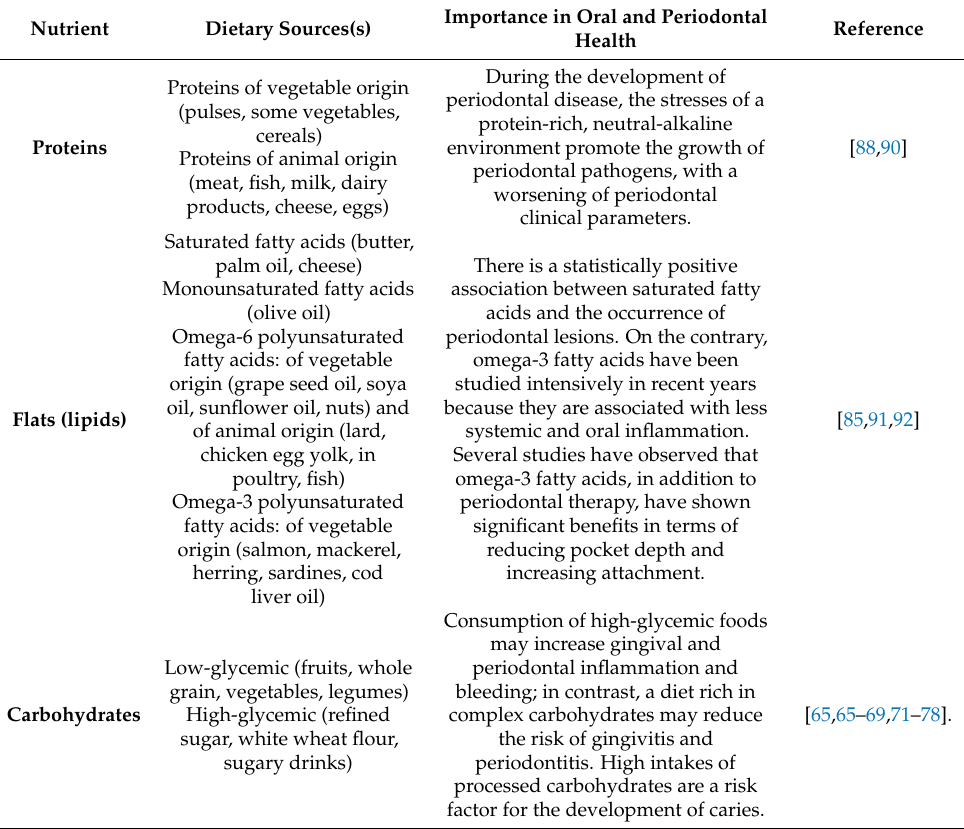
Table 1 resumes the association between macronutrients and their effects in periodon- tal tissues. Table 1. Association between macronutrients and periodontal health. Nutrient Dietary Sources(s)